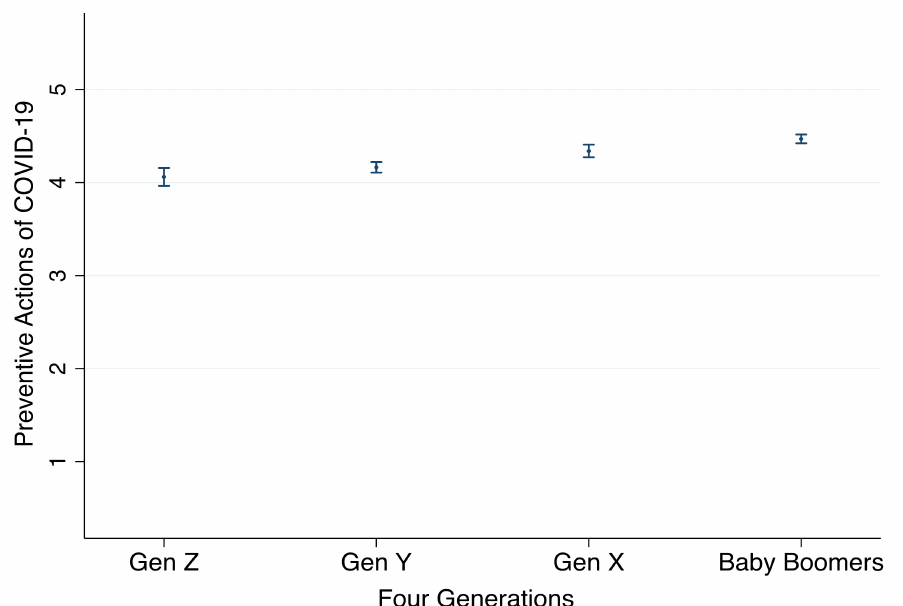
Figure 2. Comparison of Preventive Actions of COVID-19 by four generations, with 95% CI. Note: Preventive action is measured as an average of six items on a 5-point scale, with bigger values indicating that more preventive actions would be taken by respondents (see details in Table